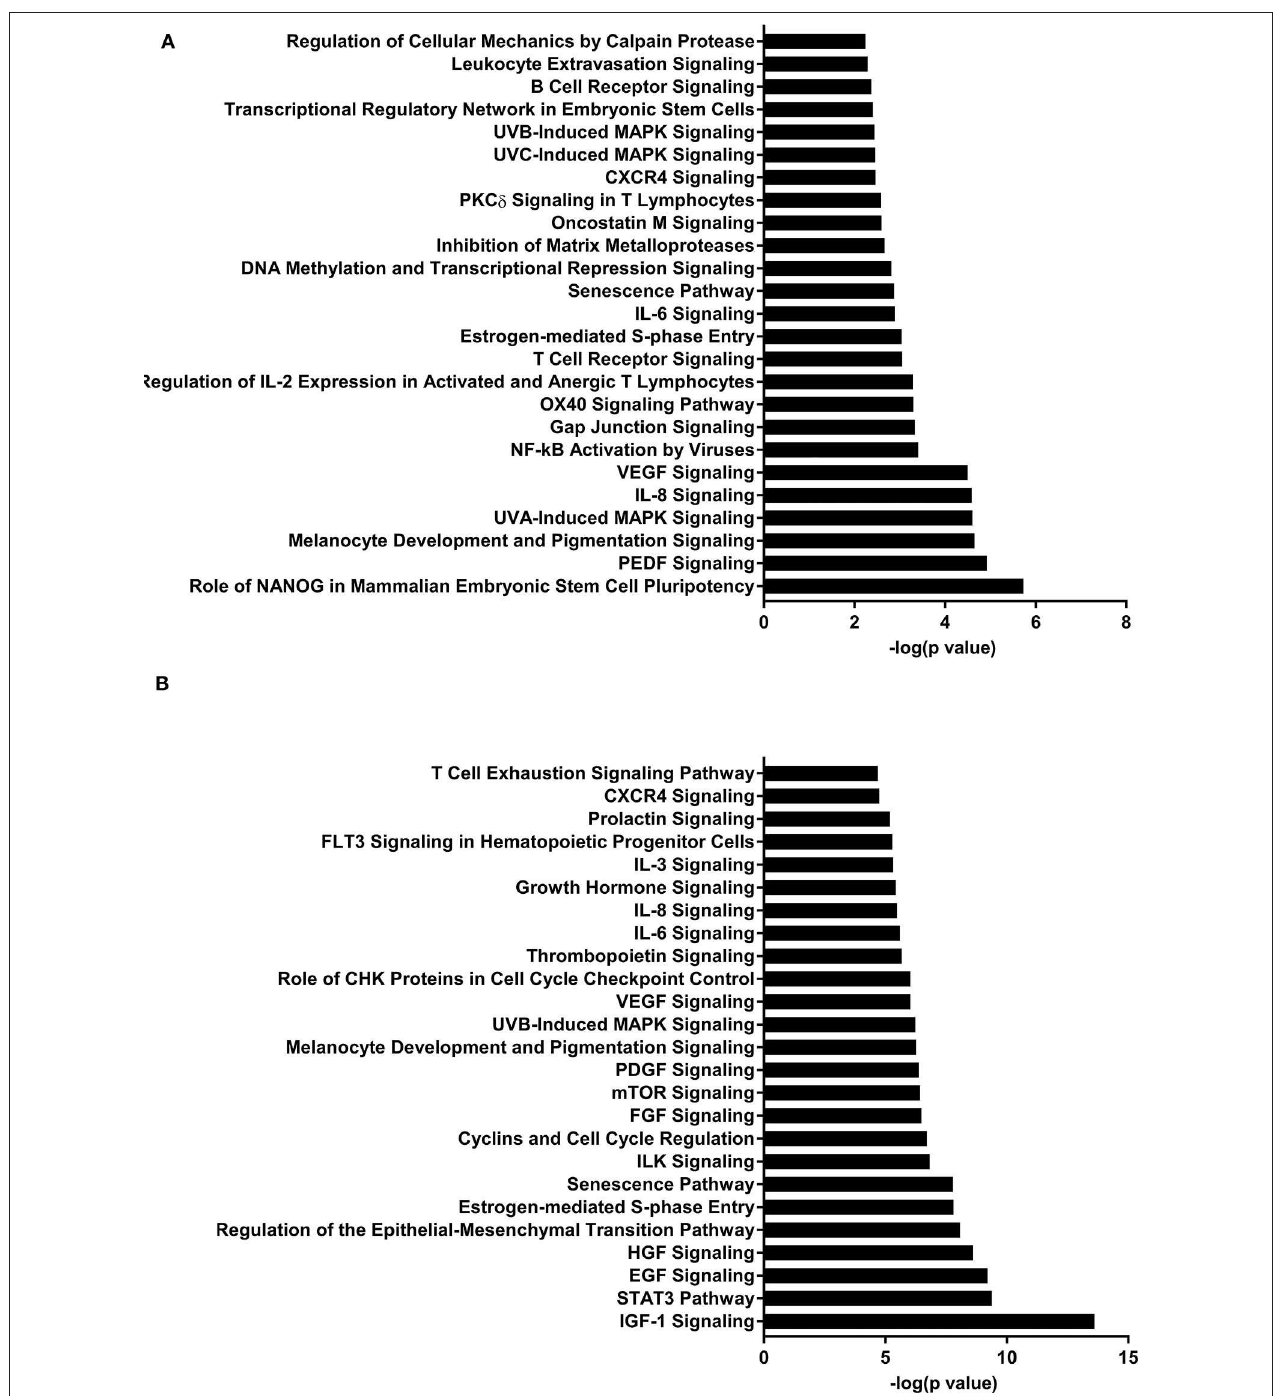
FIGURE 2 | Enriched pathways of MF compared to HM at PND21. (A) IPA of target predicted genes for downregulated miRNA in MF relative to HM at PND21. (B) IPA of target predicted genes for upregulated miRNA in MF relative to HM at PND21. The data represents from 9 MF and 9 HM fed